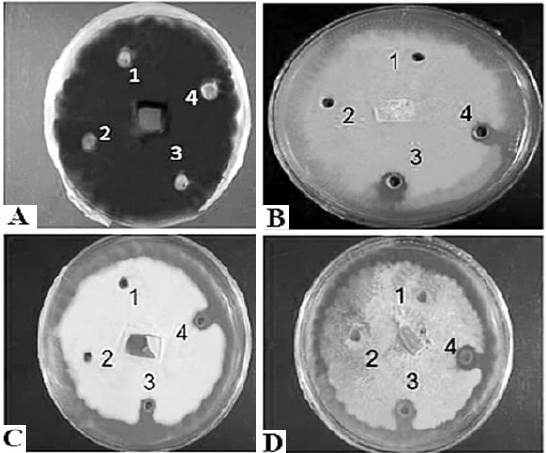
Fig. 5. Radial diffusion assay: A) B. cinerea ; B) S. sclerotiorum ; C) V. dahila D) R. solani. [1= Protein of non-induced bacteria; 2= Protein of bacteria with empty vector (as negative controls); 3 and 4= Extracted fused protein (two